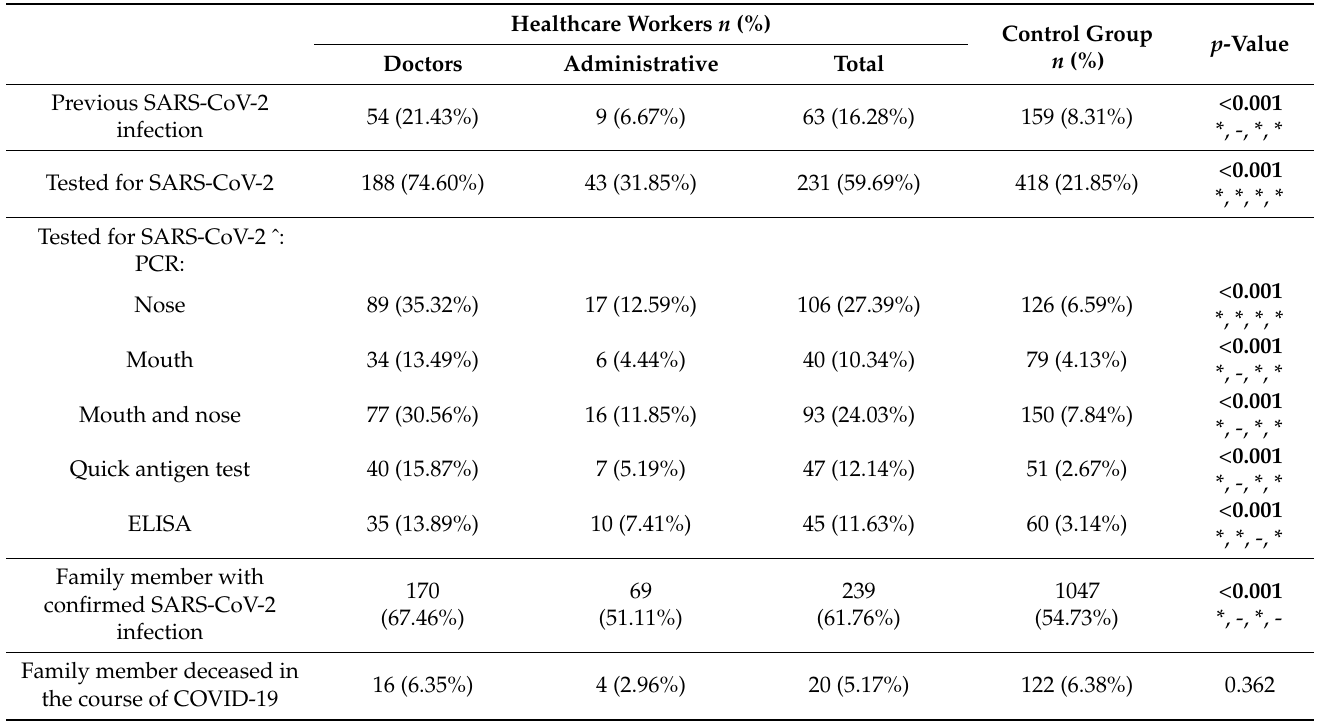
Table 2. Experiences with COVID-19 and the related anxiety among control group and healthcare